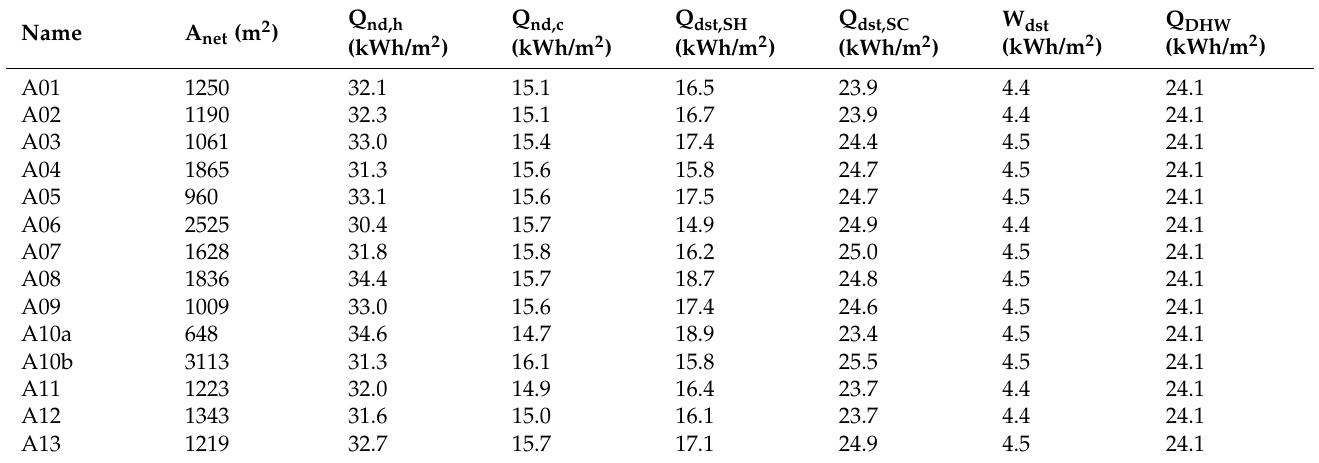
Table 3. Building energy needs and energy demand of the distribution